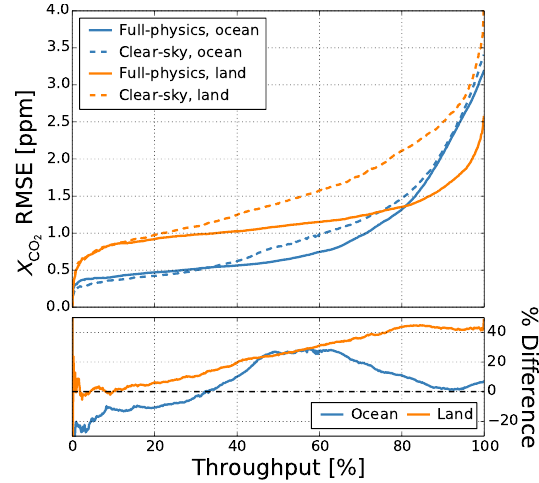
Figure 4. DOGO filters applied to full-physics (solid) and clear- sky (dashed) retrievals performed on simulated OCO-2 measure- ments for ocean (blue) and land (orange) surfaces. Four variables were chosen and optimized by the DOGO system. The x axis is throughput, which represents the percentage of data that remains after applying the DOGO filters. The y axis in the top panel is the X CO RMSE. The y axis in the bottom panel is the percent differ- 2 ence between the clear-sky X CO RMSE ( E 1 ) and the full-physics 2 X CO RMSE ( E 2 ): (E 1 − E 2 )/( 0 . 5 · (E 1 + E 2 )) · 100. Positive values 2 indicate smaller full-physics X CO RMSEs, while negative values 2 indicate smaller clear-sky X CO 2